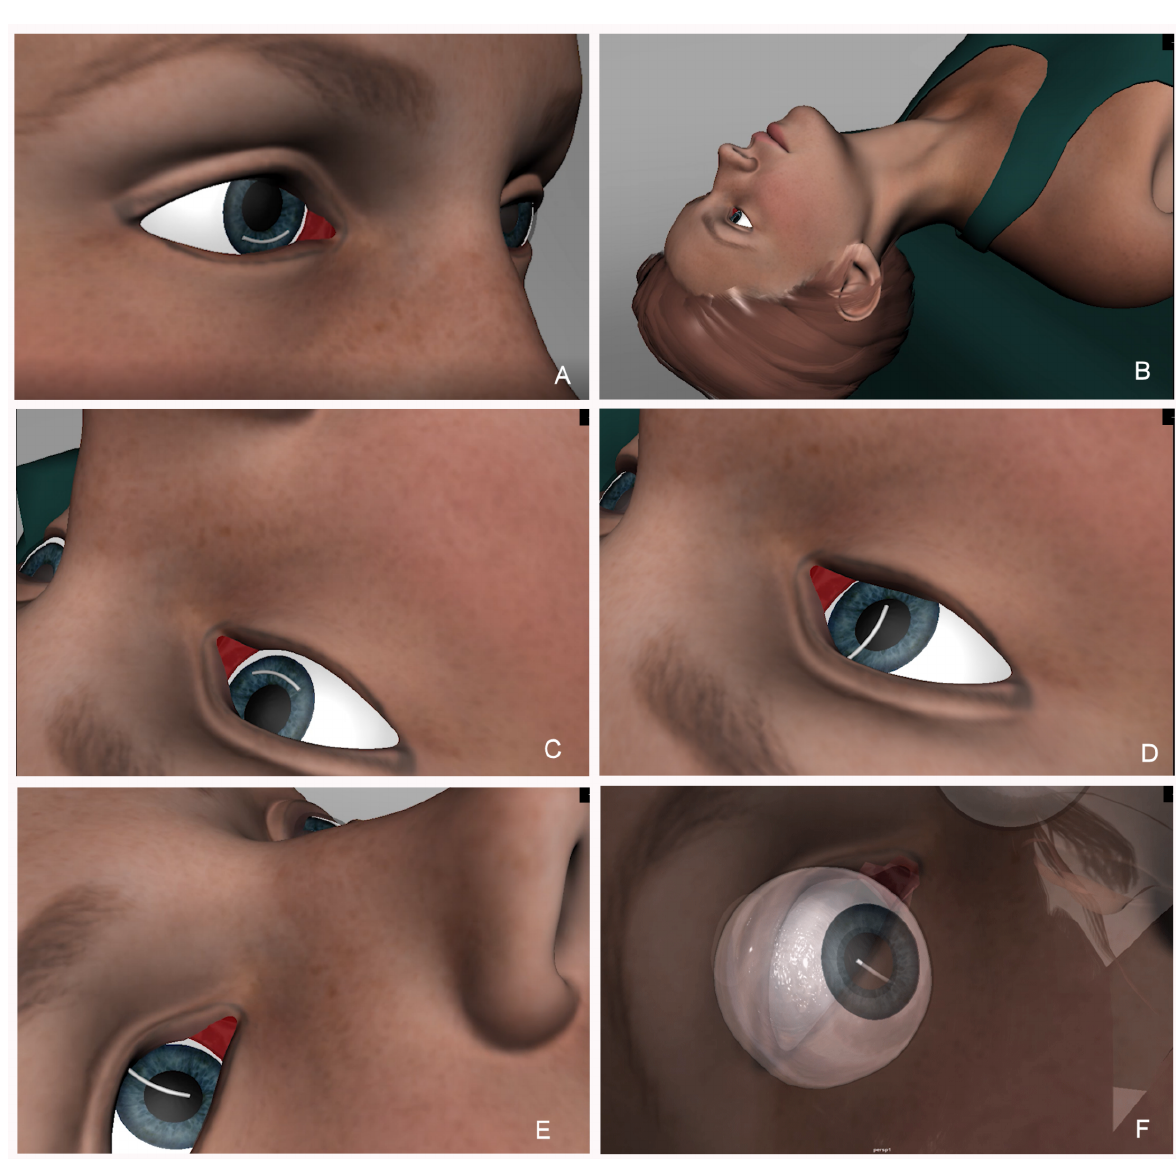
Figure 1: A) Ozurdex ® located in the inferior angle. B) The patient lies in supine, with the head leaning out. C) At first, the implant does not move. D) With gentle massage, the implant moves to the superior angle, in vertical position. E) The patient’s head is elevated so the inferior tip of the implant can pass under the pupil. F) When the patient looks down, the implant moves back to the vitreous chamber.